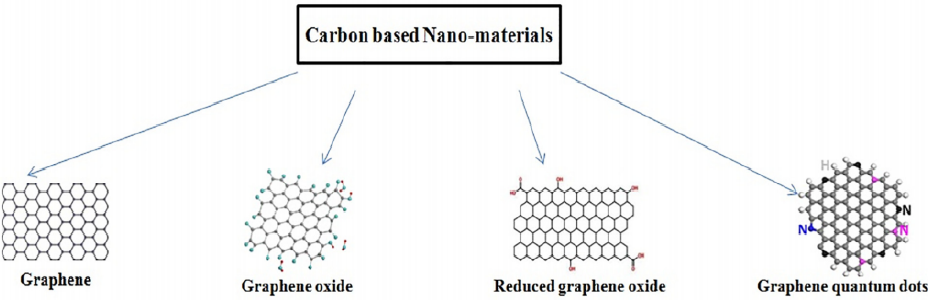
Figure 1. Various forms of Graphene. “Reproduced with permission from [10], [FlatChem]; published by Elsevier, 2020”.